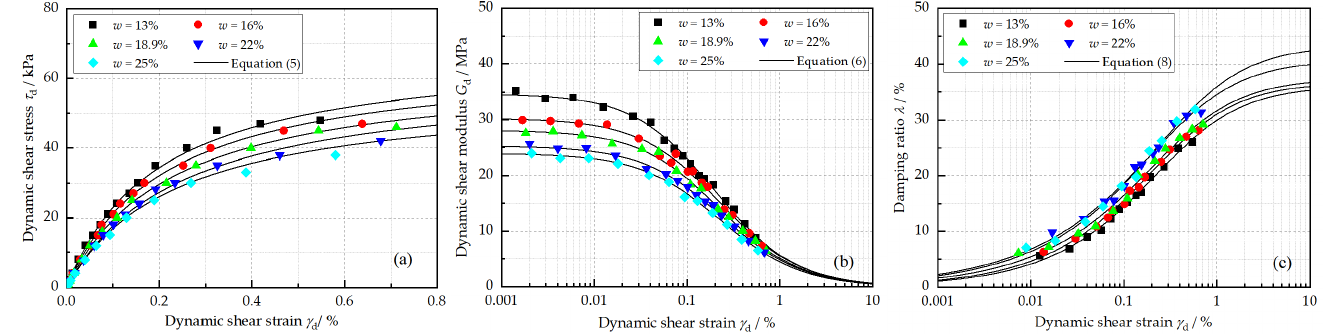
Figure 8. Effects of initial water content on ( a ) backbone curve, ( b ) dynamic shear modulus, and ( c ) damping ratio under the conditions of N = 5, C FA = 20%, C PF = 0.5%, and σ 3 = 100